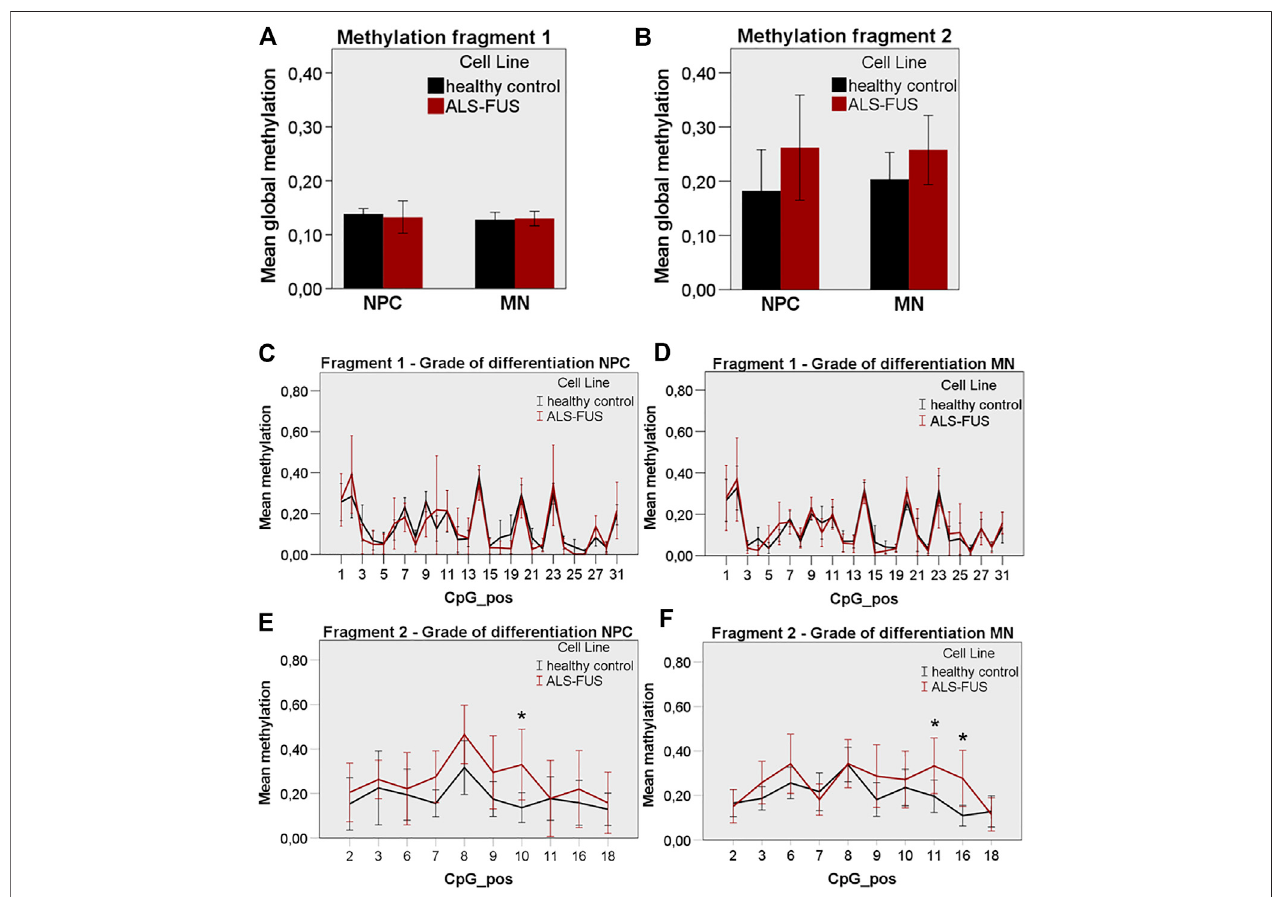
FIGURE 4 | FUS promoter methylation in control and ALS cell lines, (A) ALS cell lines showed similar global FUS promoter methylation in NPC and MN state comparedtocontrolcelllinesinfragment1, (B) ALScelllinesshowednon-signi fi cantlyincreasedglobal FUS promoterhypermethylationinNPCandMNstatecompared to control cell lines in fragment 2, (C) No signi fi cant CpG site-speci fi c methylation difference in control and ALS NPCs and, (D) MNs in fragment 1, (E) Signi fi cant CpG site-speci fi chypermethylationinALSNPCsatposition10and, (F) inALSMNsatposition11and16infragment2.Statisticalinferences weredrawnfromunpaired t -test and illustrated as mean ± SEM. Results were regarded as statistically signi fi cant with p < 0.05, n (cid:2) 3 per condition and n (cid:2) 3 per cell line.